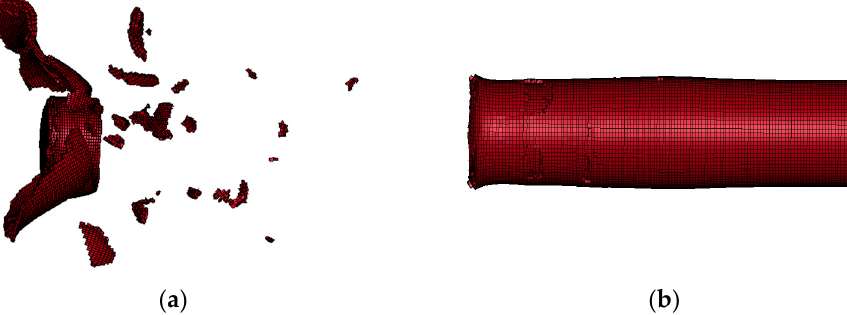
Figure 4. Shell of the PELE projectile after penetrating the steel target: ( a ) conventional PELE projectile and ( b ) truncated conical PELE projectile.